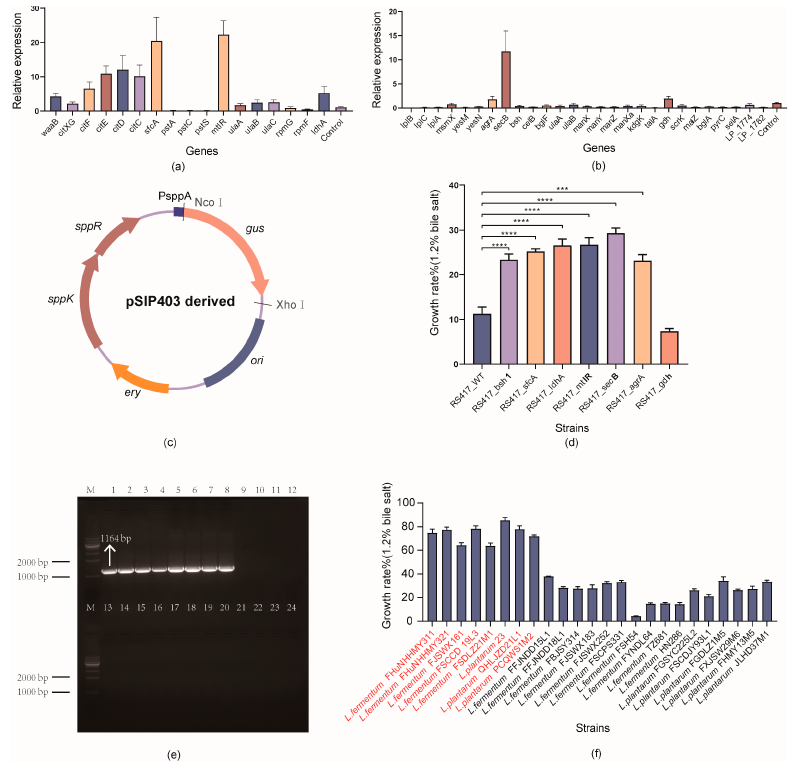
Figure 5. Validation of the functional genes by qPCR, overexpression in lactobacilli , and rapid screening of bile salt-resistant lactobacilli by novel target genes. ( a , b ) Relative expression of genes in L. fermentum 156 and L. plantarum S83, respectively. ( c ) pSIP403-series plasmid. ( d ) Growth rate of the induced strain in the presence of 1.2% bile salt; *** p < 0.001, **** p < 0.0001. ( e ) Rapid screening of tolerant strains by PCR amplification. ( f ) Growth rate of 24 lactobacilli under 1.2% bile salt treatment (strains from left to right correspond to lanes 1–24 in ( d